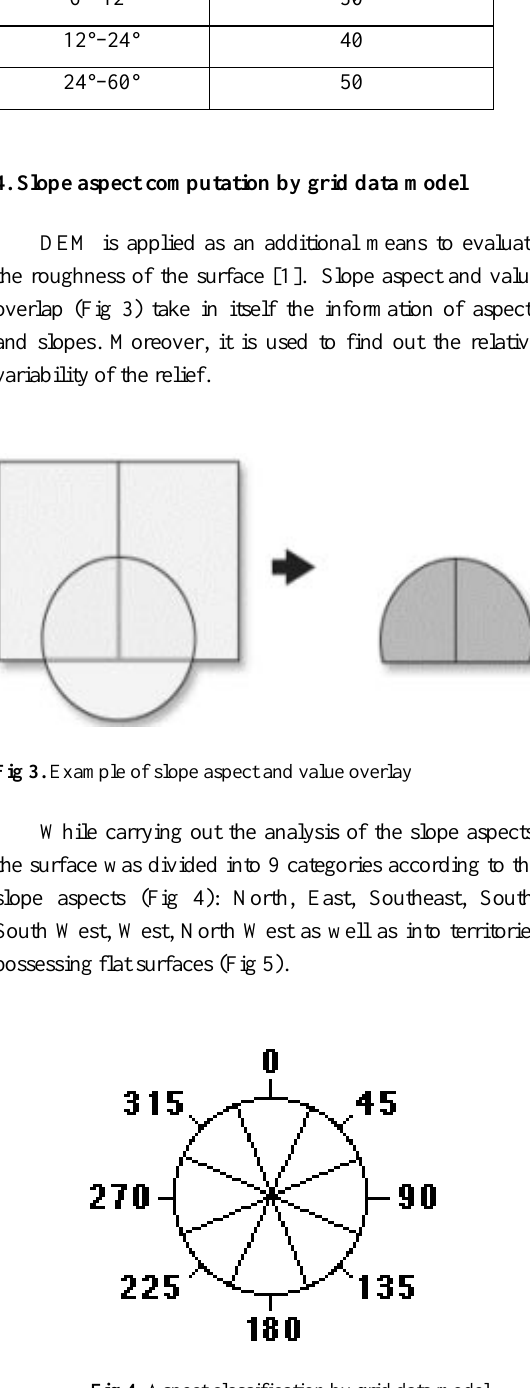
Fig 2. Representation of slope values in the slope model